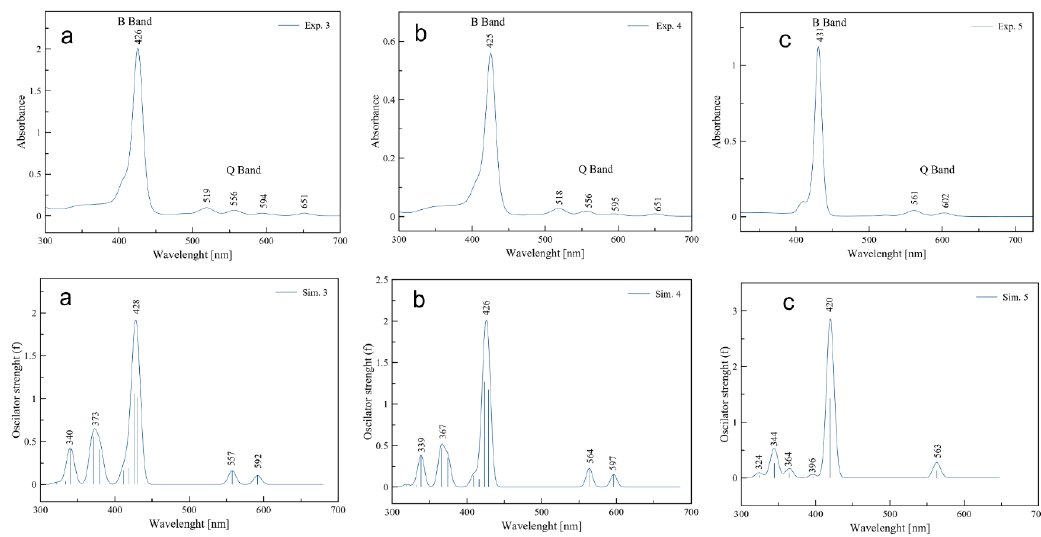
Figure 8. Simulated and experimental UV-Vis spectra in N, N-dimethylformamide of compounds 3 ( a ); 4 ( b ) and 5 ( c ). Upper spectra are experimental while lower are simulated. The applied FWHM parameter of the simulation curves was equal to 12.